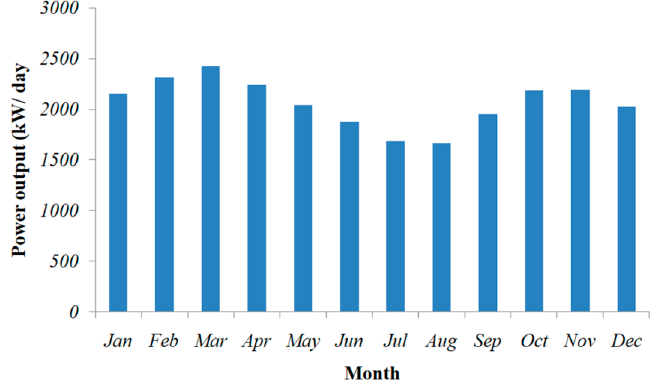
Figure 16. Electricity production in each month from PV–BSS configuration.